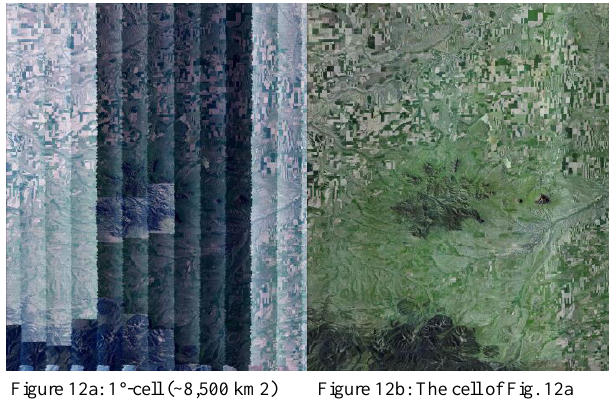
Figure 12a: 1°-cell (~8,500 km2) before color balancing